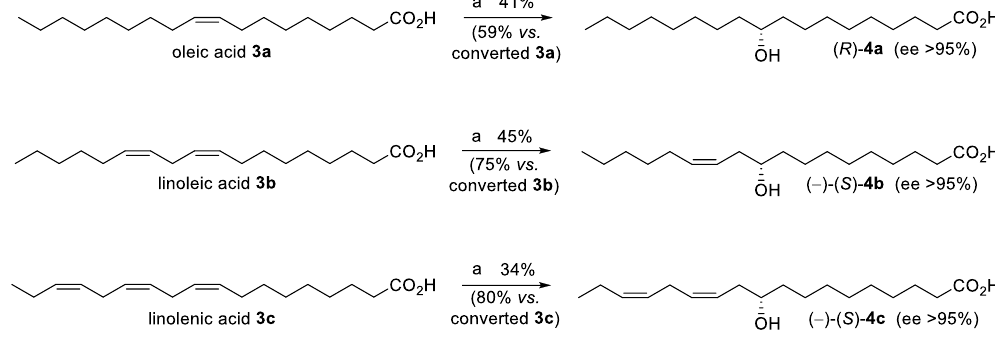
Figure 3. Whole-cell based biotransformation of oleic, linoleic and linolenic acid using Lactobacillus rhamnosus (ATCC 53103). Experimental conditions: (a) anaerobic fermentation, MRS broth, 37 °C, pH 6.2, 170 rpm, fatty acid concentration 5 g/L.